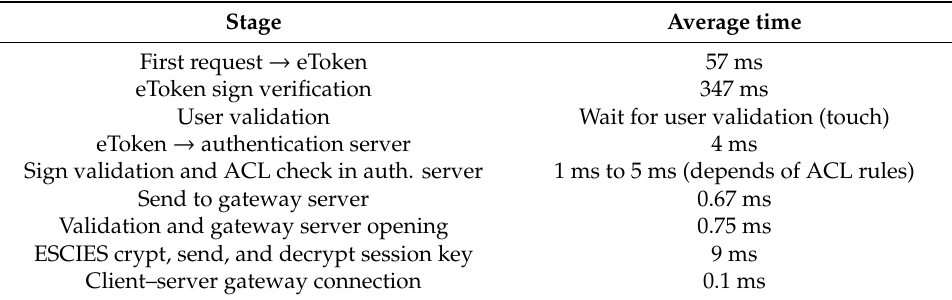
Table 10. Mean time for di ff erent